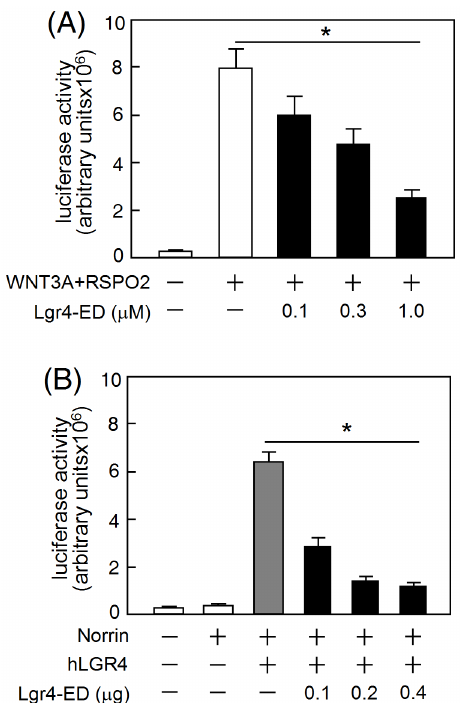
Figure 3. Antagonist effects of Lgr4-ED. (A) For the R-spondin assays, HEK293T cells were transfected with plasmids encoding TOPFLASH, CMV- b -Gal and human LGR4. At 24 h after transfection, cells were further treated with WNT3A, RSPO2 and graded amounts of purified Lgr4-ED as indicated. (B) For the norrin assays, HEK293T cells were co-transfected with TOPFLASH, CMV- b -Gal, LGR4, norrin and increasing amounts of rat Lgr4-ED plasmids as indicated. After recovery in serum-containing medium for 24 h, the cells were incubated in the serum-free medium for 16 h before performing luciferase assays. Luciferase data were normalized against the b -galactosidase levels and are shown as the mean 6 SD of triplicates (*, P , 0.05). Three additional experiments were performed and all three produced similar results.